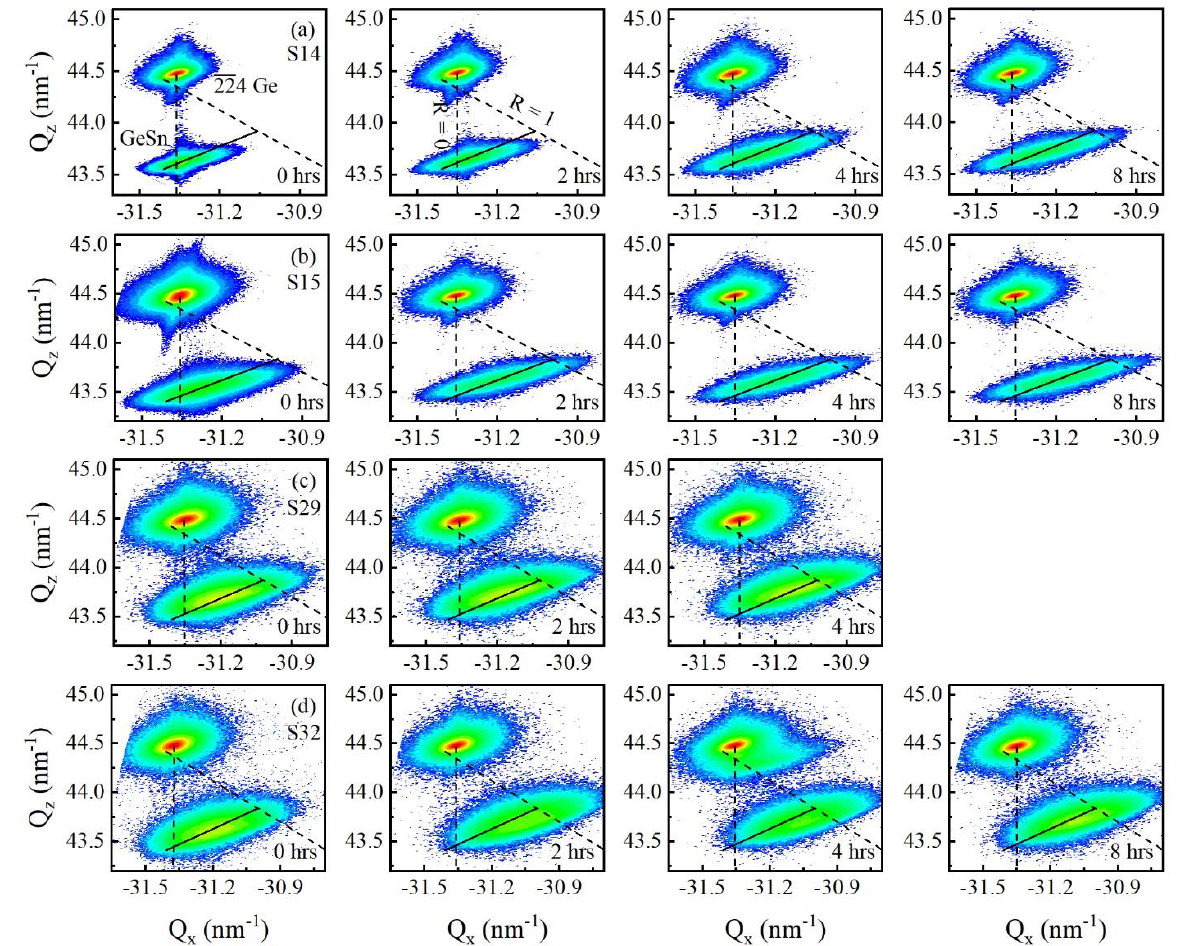
Figure 2. X-ray diffraction 2̅2̅4 RSMs for samples ( a ) S14, ( b ) S15, ( c ) S29, and ( d ) S32 measured after the annealing for 0, 2, 4, and 8 hours. The vertical and inclined dashed lines mark the fully strained and fully relaxed GeSn alloy with respect to Ge buffer. The solid line is the isocomposition line for the GeSn layers of each sample. The 2̅2̅4 RSM was not measured for sample S29 annealed for 8 hours since no changes in the strain state and Sn content in the GeSn layer was concluded by comparing the 004 ω/2θ scans for sample S29 annealed for 4 and 8 hours. For a biaxially strained GeSn layer, the Sn composition, 𝑥 , and strain state were ob- tained according with the following equations,